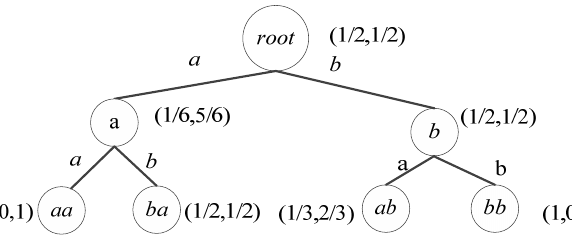
ffi x Tree ( PST ) representation for “ abbabbabaaba Figure 1. Probabilistic Suffix Tree ( PST ) representation for “ abbabbabaaba ” . Figure 1. Probabilistic Su